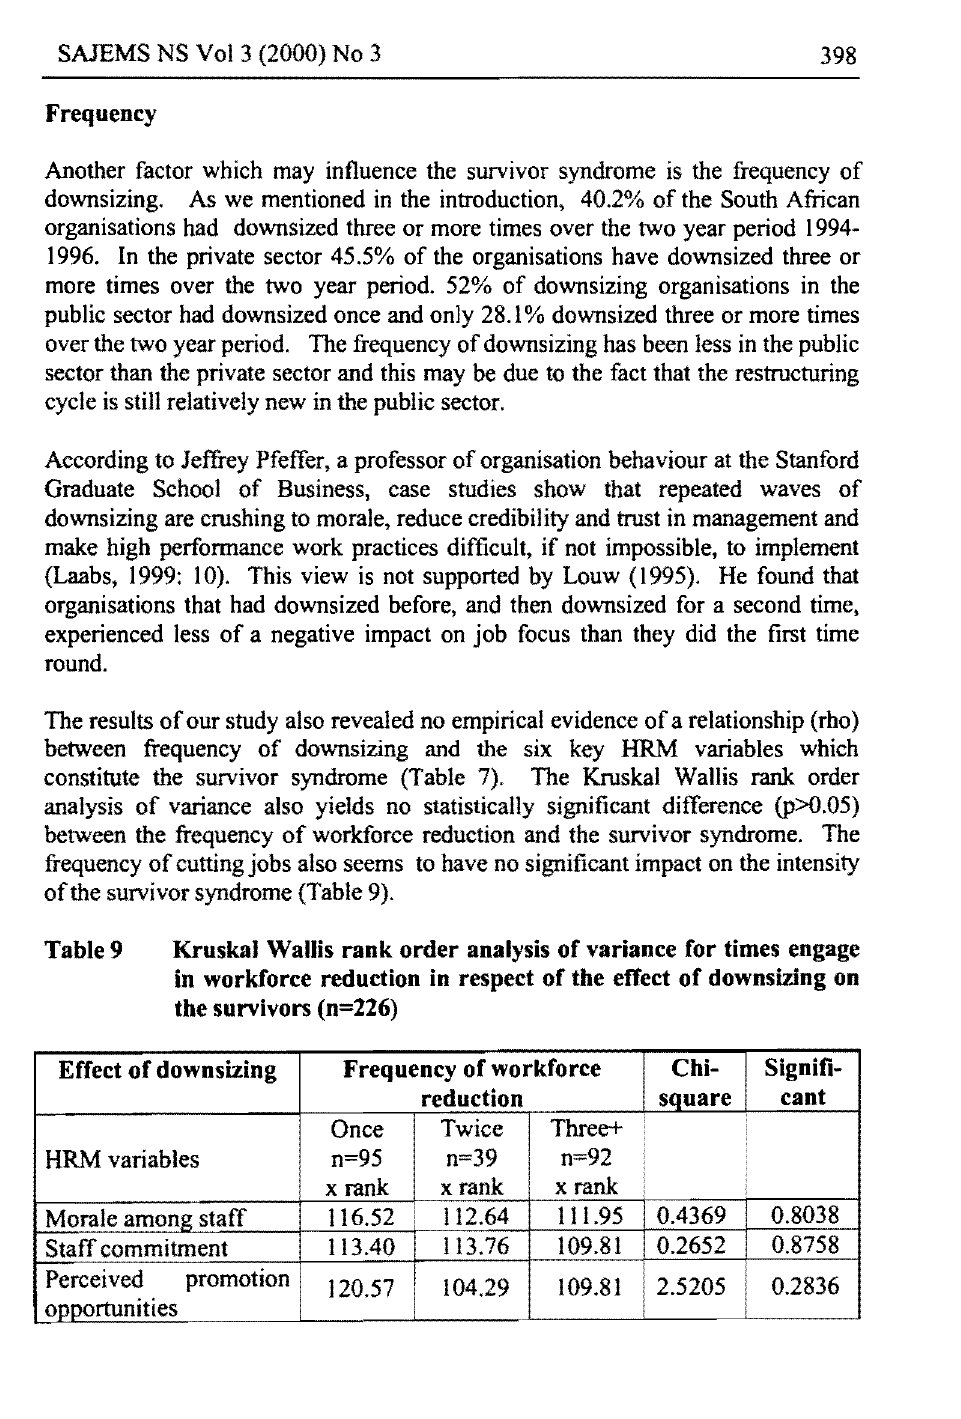
Kruskal Wallis rank order analysis of variance for times engage in workforce reduction in respect of the effect of downsizing on the survivors